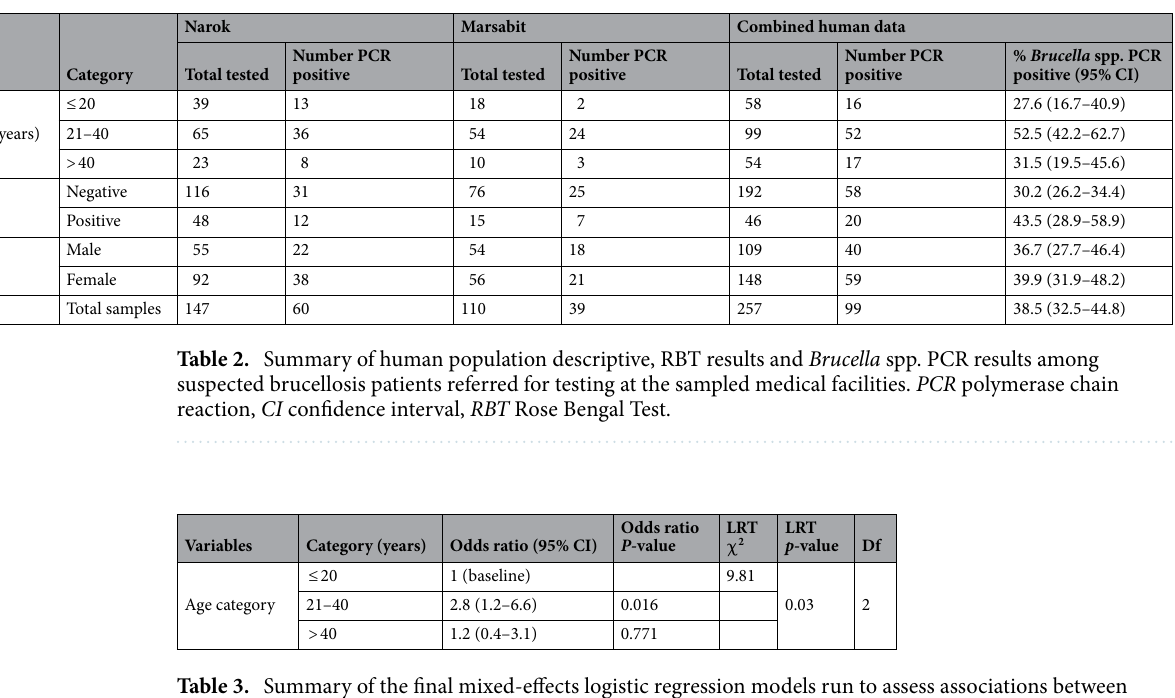
Table 3. Summary of the final mixed-effects logistic regression models run to assess associations between variables and Brucella spp. PCR status in human. CI confidence interval, LRT χ 2 Likelihood Ratio Test Chi- square value, P-value according to Pearson Chi-square test, Df degrees of